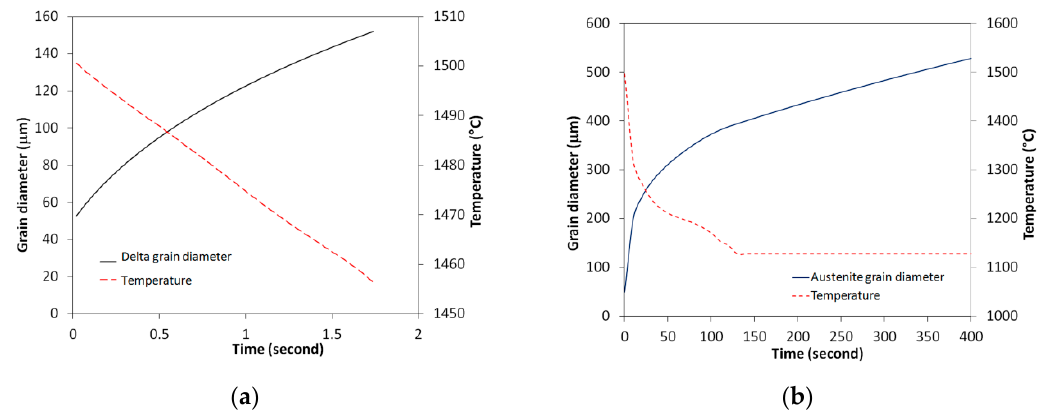
Figure 5. ( a ) The predicted delta grain size evolution with time 5 mm below the slab surface; and ( b ) the predicted austenite grain size evolution at the same position before entering the roller hearth holding furnace.